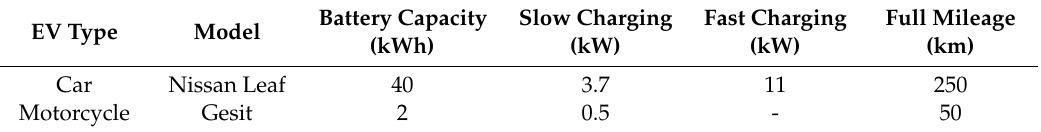
Table 1. EV parameters.